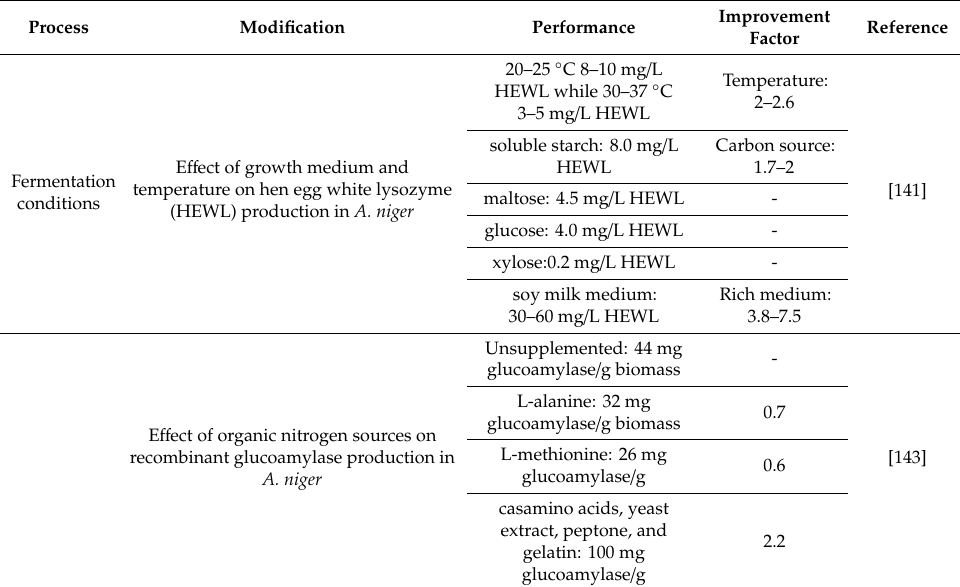
Table 12. Approaches for improving recombinant protein production through bioprocessing